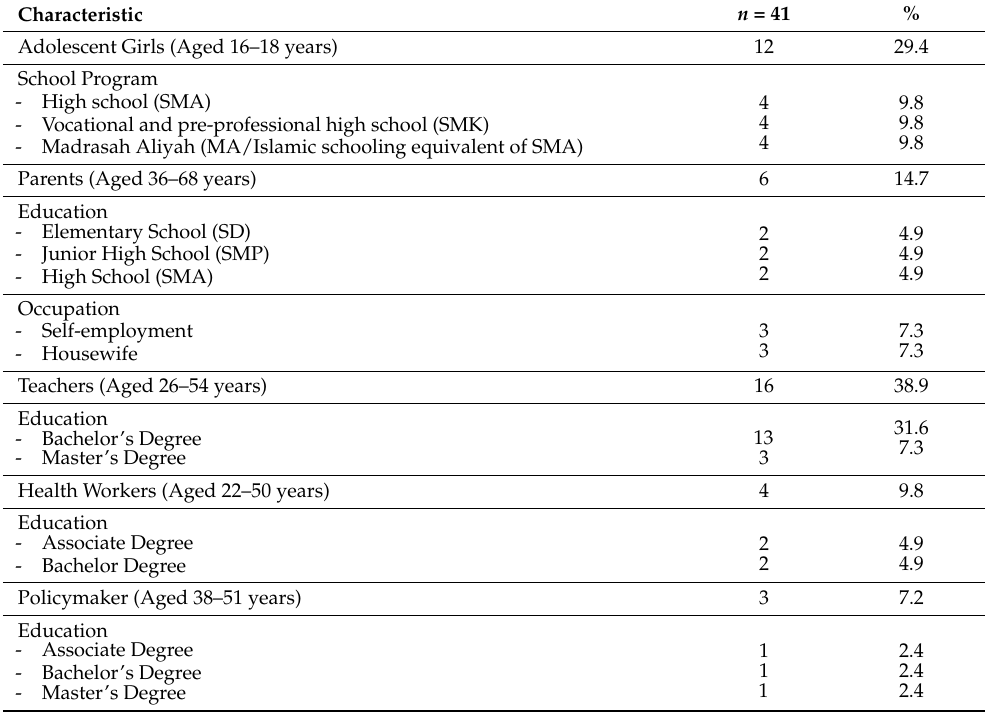
Table 1. Sociodemographic characteristics of the participants.